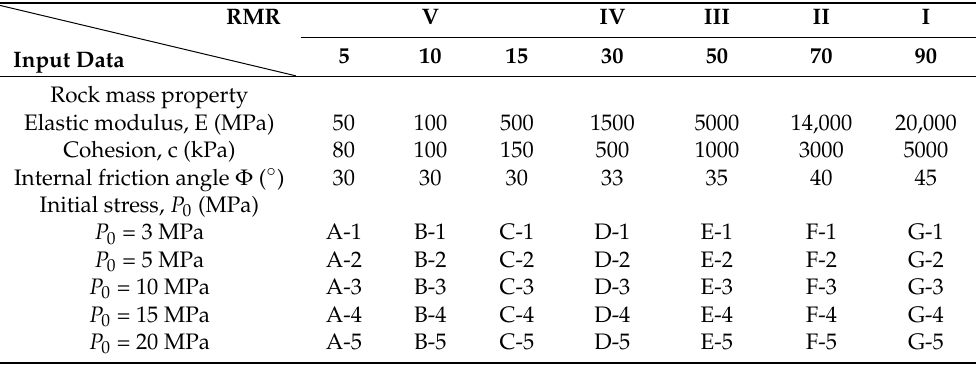
Figure 6. Construction site referenced for the properties of material: ( a ) location map; and ( b ) geological structure of the study area. Table 1. Numerical modeling data for evaluating the LDP under different rock mass qualities and initial stress conditions.